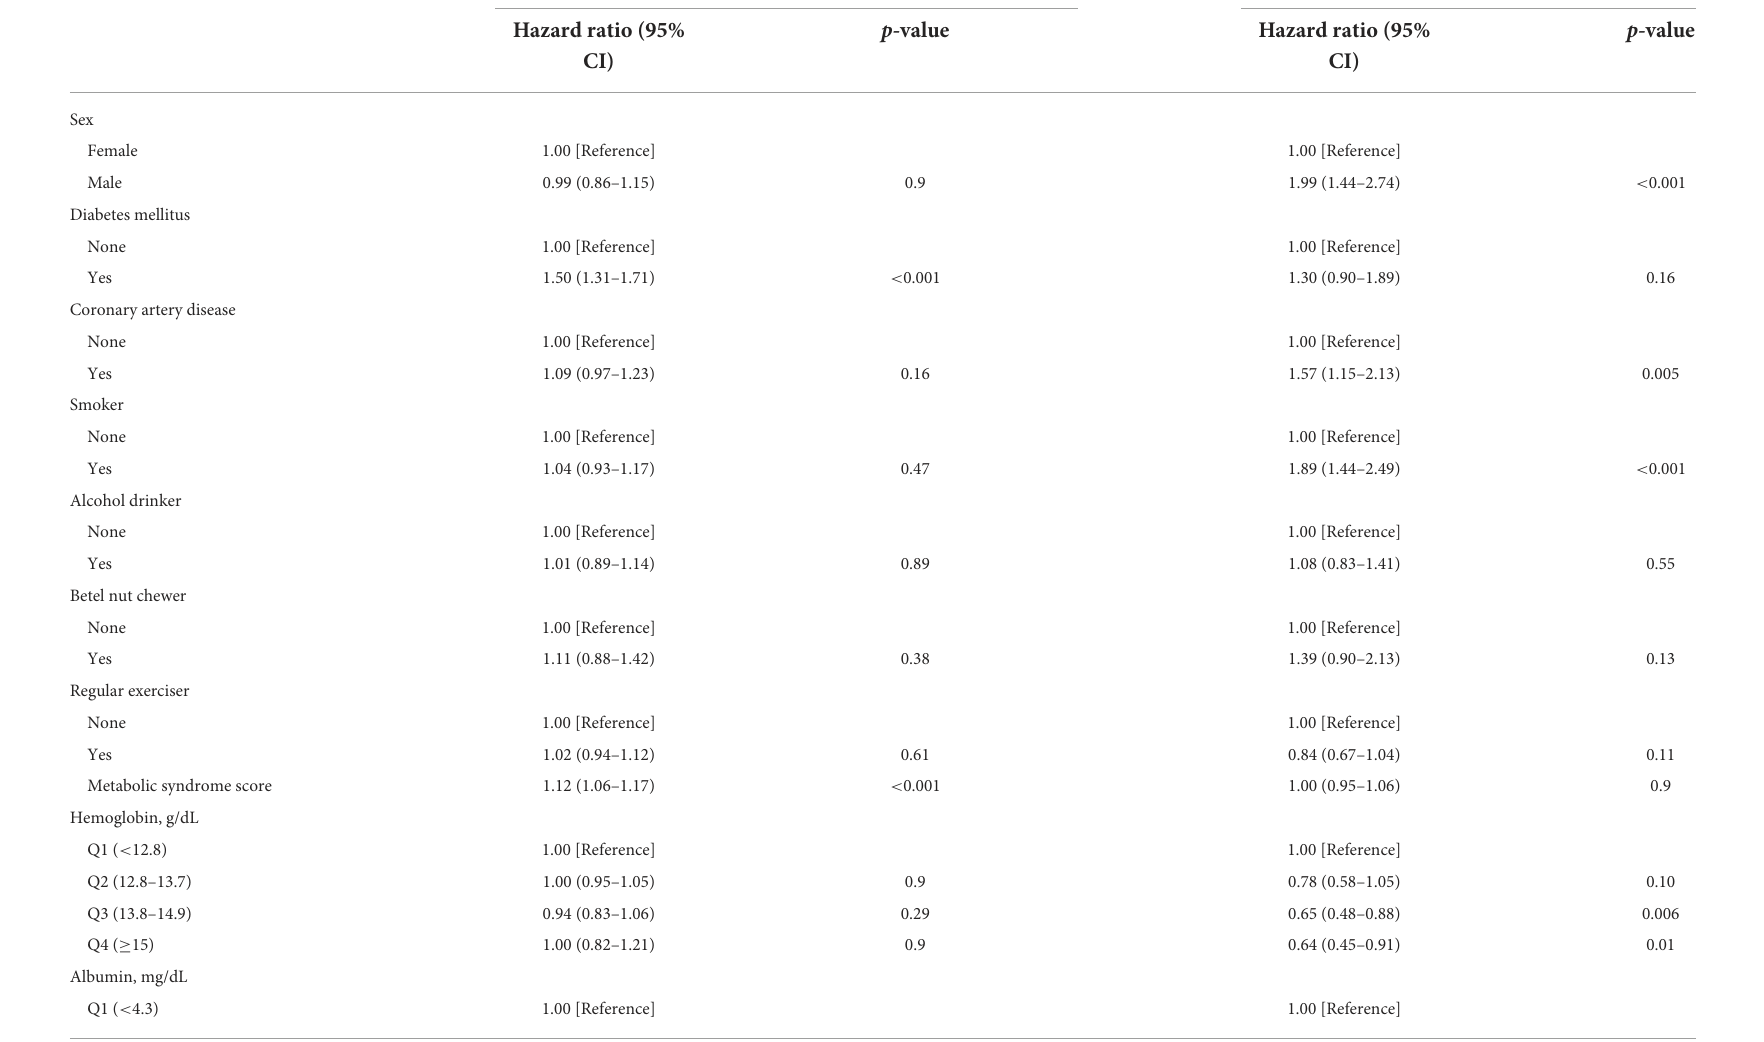
TABLE 2 Factors associated with transiting to estimated glomerular filtration rate (eGFR) < 60 mL/min/1.73 m 2 or death in the cohort with baseline eGFR ≥ 60 mL/min/1.73 m 2